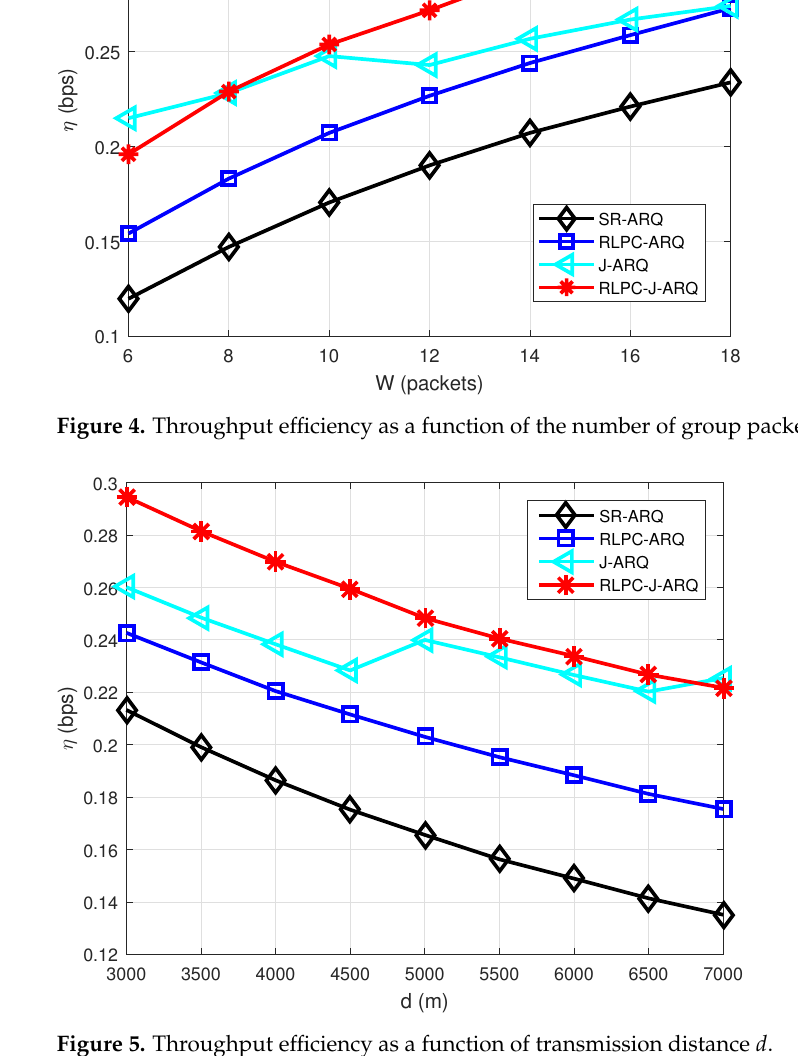
Figure 5. Throughput efficiency as a function of transmission distance d